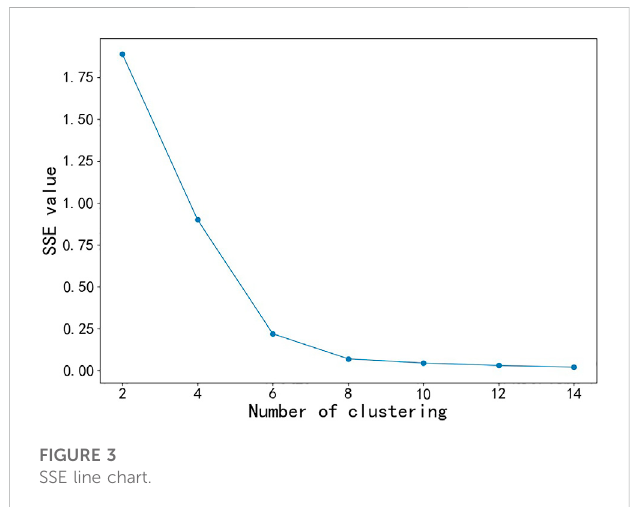
FIGURE 3 SSE line